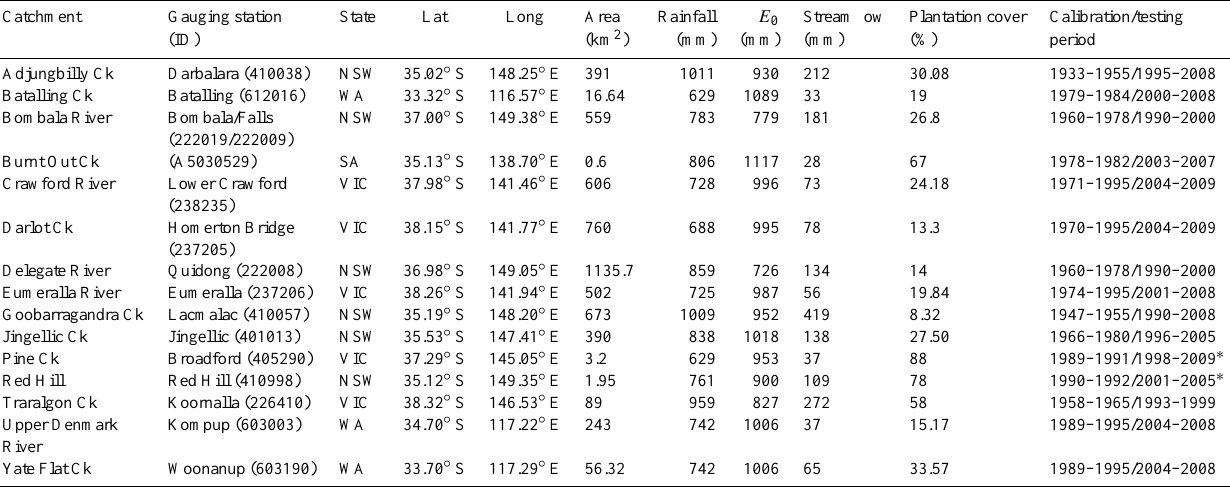
Table 1. Summary of selected catchments for plantation impact assessment.